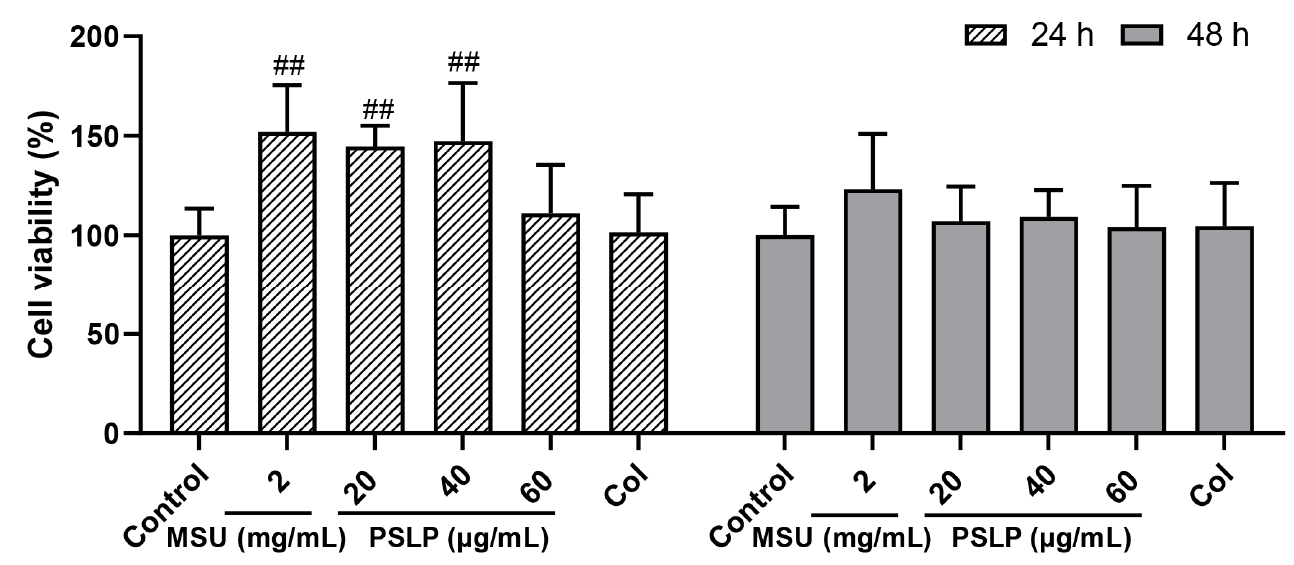
Figure 1. Effect of PSLP on the viability of RAW264.7 cells. The values were expressed as means ± SD ( n = 3), ## p < 0.01 vs. the MSU group.